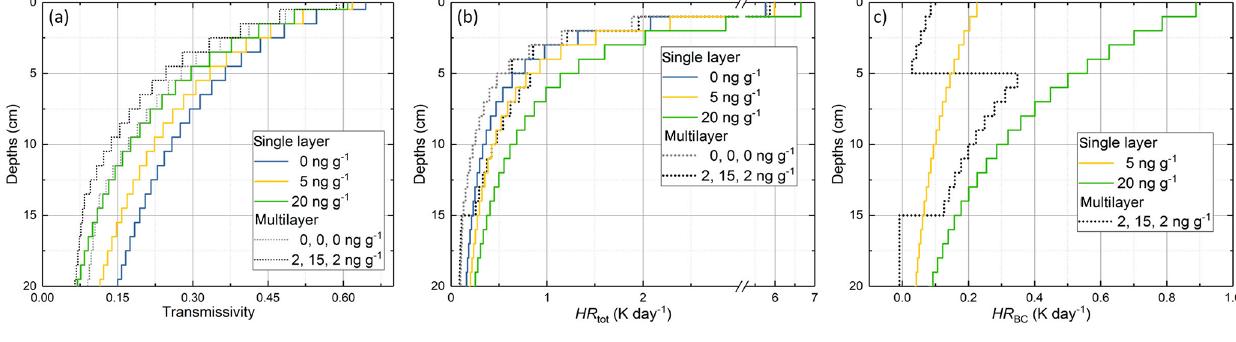
Figure 8. (a) Transmissivity profiles of solar radiation within the snowpack for three single layers and one multilayer case assuming ACLOUD conditions. (b) Corresponding daily mean total heating rate profiles within a snowpack HR tot (z) . (c) Corresponding effective BC heating rate profiles HR BC (z)